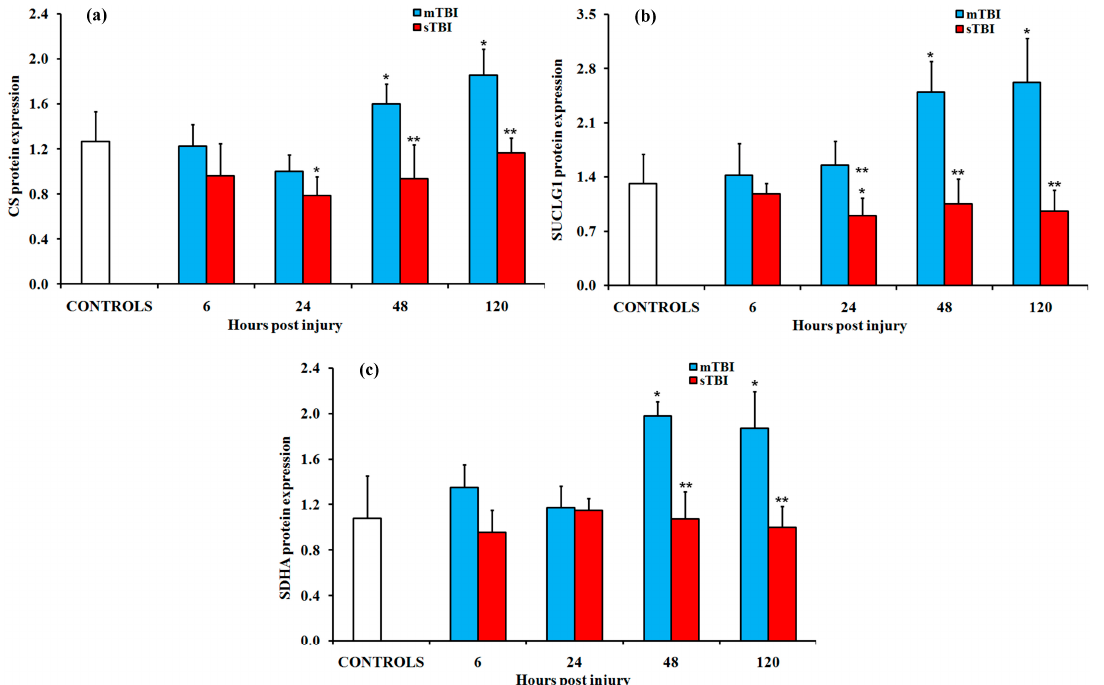
Figure 9. Changes in the protein expression of ( a ) citrate synthase (CS), ( b ) the α subunit of succinyl-CoA ligase (SUCLG1), and ( c ) the A subunit of succinate dehydrogenase (SDHA) in the brain tissue homogenates of rats receiving a TBI of di ff erent severities (mTBI or sTBI), at various times post-injury. Values are the mean of six animals. Standard deviations are represented by vertical bars. Protein expressions were measured using proper ELISA kits, as described under Materials and Methods. Values in TBI rats were normalized to the values determined in control sham-operated animals. * significantly di ff erent from the controls, p < 0.05. ** significantly di ff erent from the corresponding time of the mTBI rats, p < 0.05.